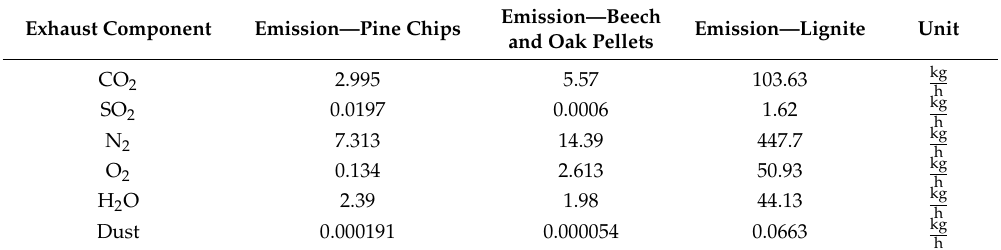
Table 7. Calculated emission of exhaust gases during the combustion of pine chips and beech and oak pellets in comparison with brown